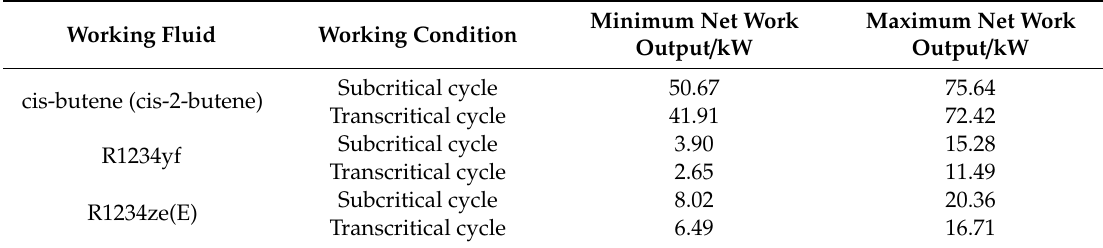
Table 5. Range of net work output of di ff erent working fluids when taking the 65% isentropic e ffi ciency of the single-screw expander into